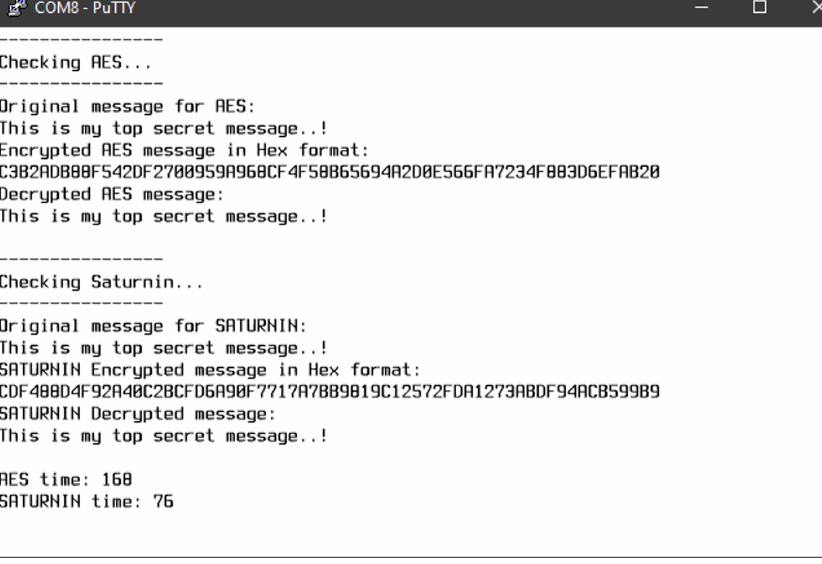
Figure 3. A screenshot after a response from the server to the client, illustrating the time needed for encryption for both AES and Saturnin (which is independent from the network and, thus,